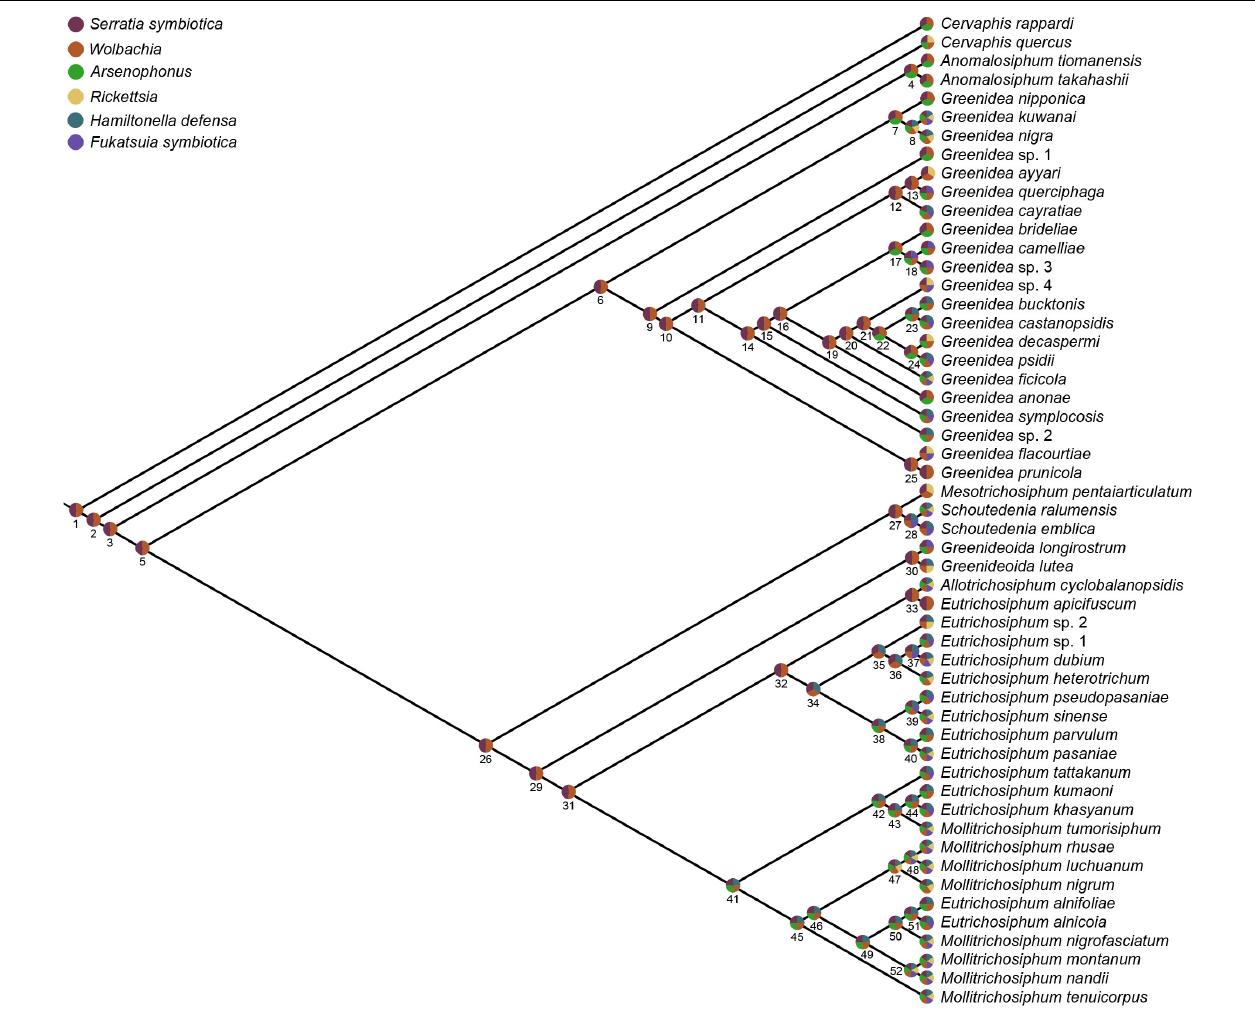
FIGURE 6 | Ancestral associations of secondary symbionts and Greenideinae aphid species estimated by Bayesian reconstruction. Pie charts at nodes and tips show the presence of different secondary symbionts. The mean posterior probabilities at nodes are given in Supplementary Table 8 .